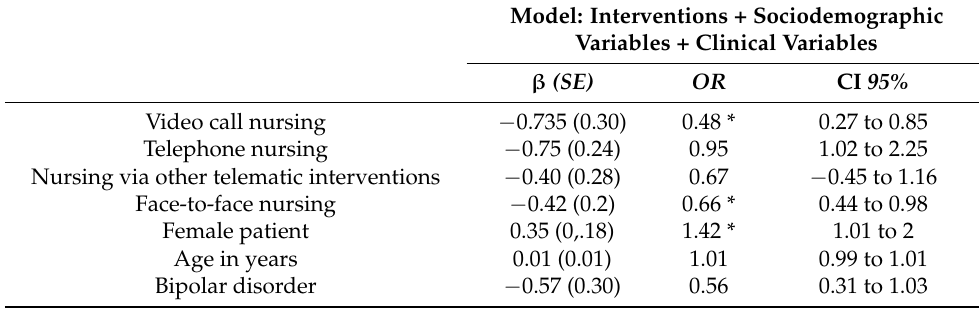
Table 4. Multilevel logistic regression analysis to predict hospitalizations six months after